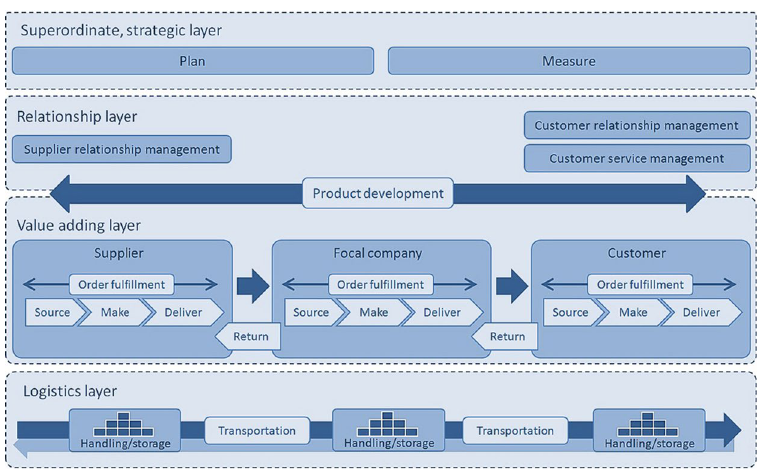
Fig. 1. Subsystems of SCM (compiled by the